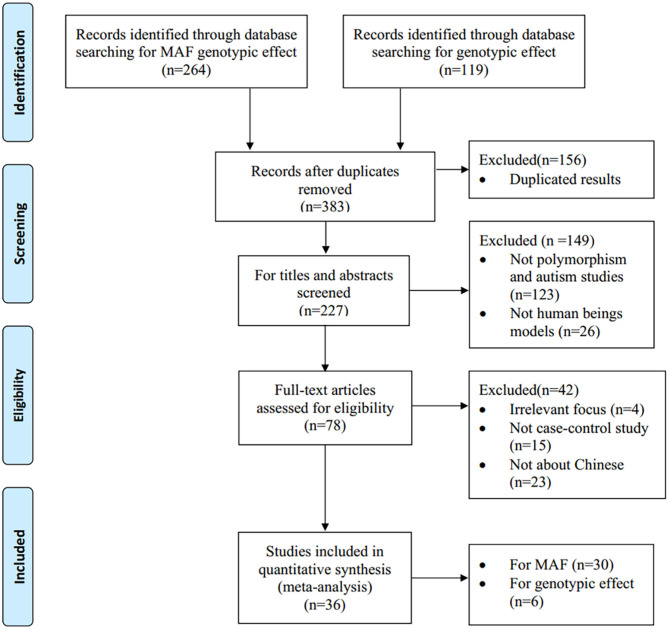
Flow chart of the study selection process.